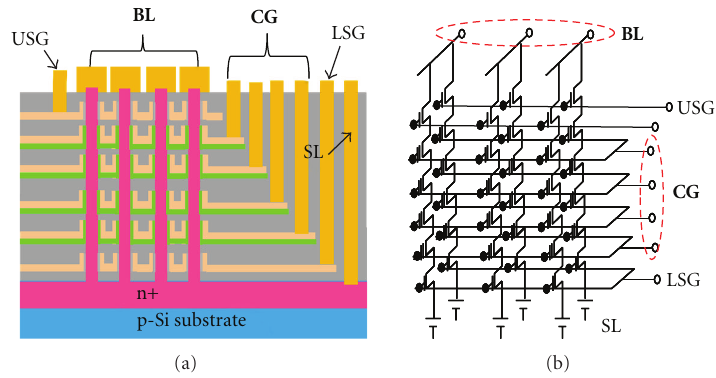
Figure 17: Schematic of 3D multilevel stacked NAND using JL-SONOS as building